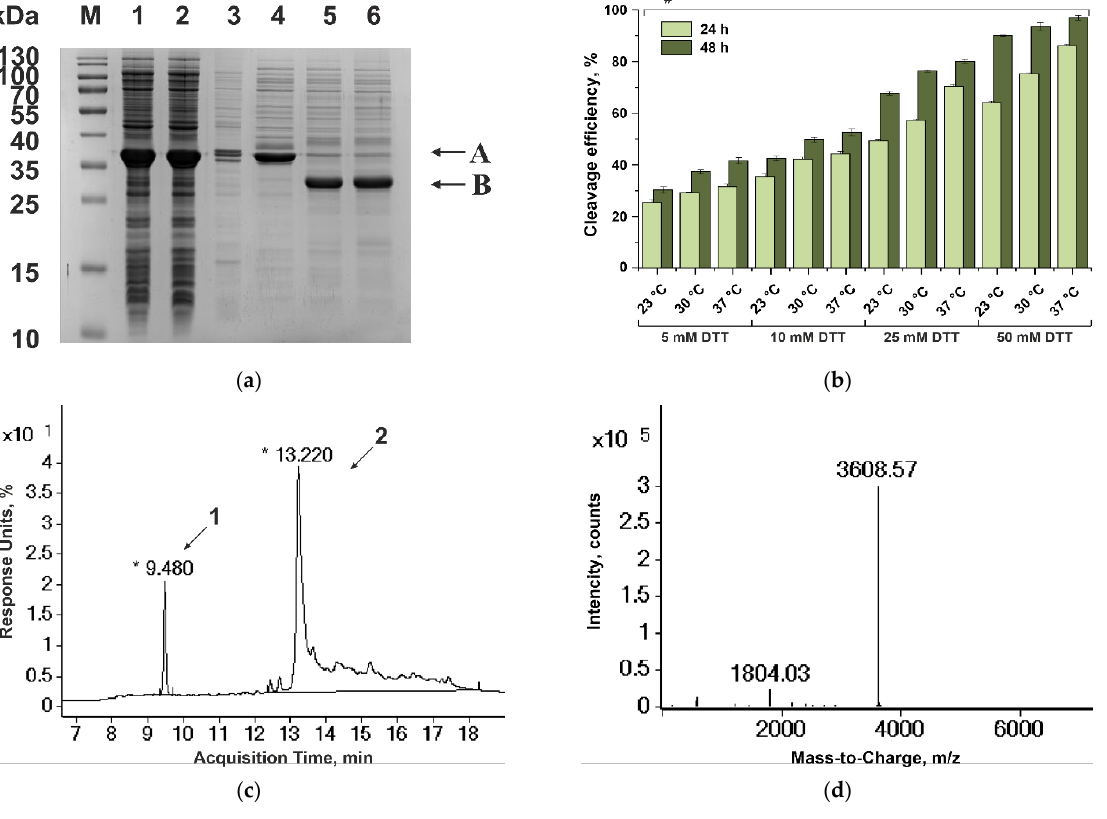
Figure 2. Purification of variegin. ( a ) SDS-PAGE analysis of purification and cleavage of Var-GyrA fusion protein. M, molecular mass markers; lane 1, crude cell lysate; lane 2, cell supernatant; lane 3, cell debris; lane 4, purified Var-GyrAfusion protein after anion IEX; lanes 5–6, products of fusion protein cleavage at pH 8.5 and 37 °C with 50 mM DTT for 24 h (lane 5) and 48 h (lane 6). Arrows indicate theVar-GyrA fusion protein (A) and residual protein CBD-GyrA (B). ( b ) Diagram of Var-GyrAfusion protein cleavage at pH 8.5 and 23, 30, and 37 °C for 24 and 48 h in the presence of 5, 10, 25, and 50 мМ DTT. * indicates p ≤ 0.05 for the comparison of incubation time between 24 and 48 h according to a Mann–Whitney test; # indicates p ≤ 0.05 for the comparison of incubation temperature between 23 and 37 °C according to a Kruskal–Wallis test. ( c ) RP-HPLC analysis of Var-GyrAfusion protein cleavage for 48 h at pH 8.5 and 37 °C with 50 mM DTT. Arrows indicate variegin ( 1 ) and residual protein CBD-GyrA ( 2 ). RP-HPLC in Y.C-Pack C8 (Octyl) column (30 nm, 3 µ m, 150 × 2.1 mm), elution with an acetonitrile gradient (8–64%) in 0.1% TFA at a rate of 0.3 mL/min. ( d ) ESI-TOF mass spectrum of